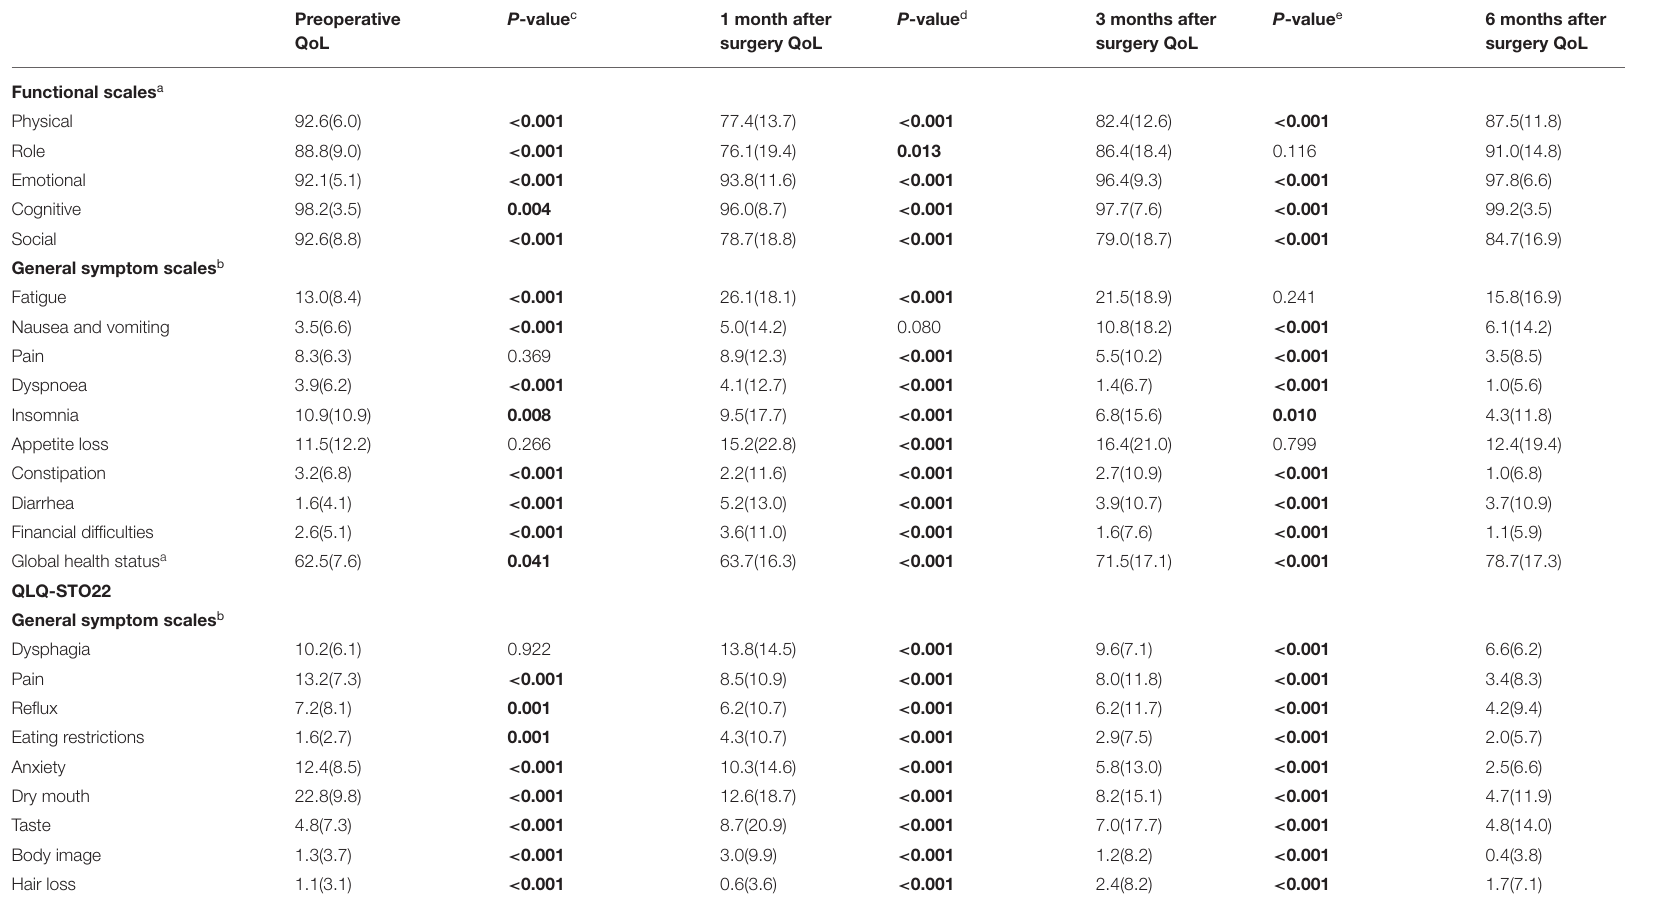
TABLE 2 | Mean scores of EORTC QLQ-C30 and QLQ-STO22